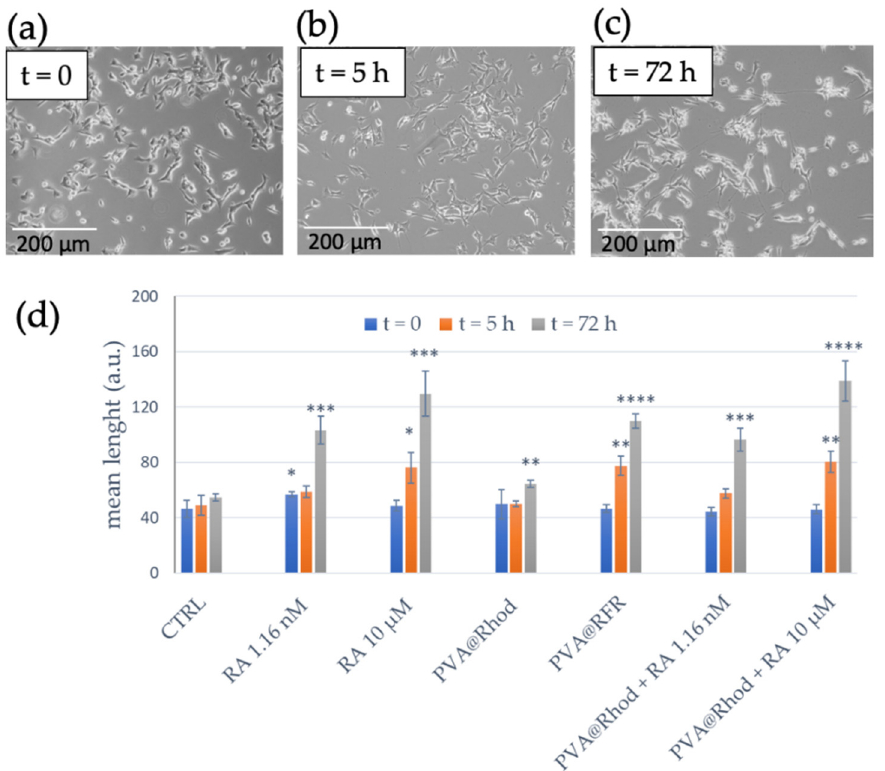
Figure 8. Representative optical phase-contrast images of the SH-SY5Y neuroblastoma cell line treated with PVA@RhodFR at the concentrations of 2.9 × 10 − 7 and 1.16 × 10 − 9 M for the polymer and retinoic acid, respectively, at t = 0 ( a ), t = 5 h ( b ), and after 72 h ( c ) of incubation (scale bar = 200 μ m). ( d ) Quantification of induced neurite outgrowth in response to the treatment of neuroblastoma cells for 5 and 72 h with: 1.16×10 − 9 and 1×10 − 5 M ATRA; 2.4×10 − 7 M PVA@Rhod; PVA@RhodFR (2.9×10 − 7